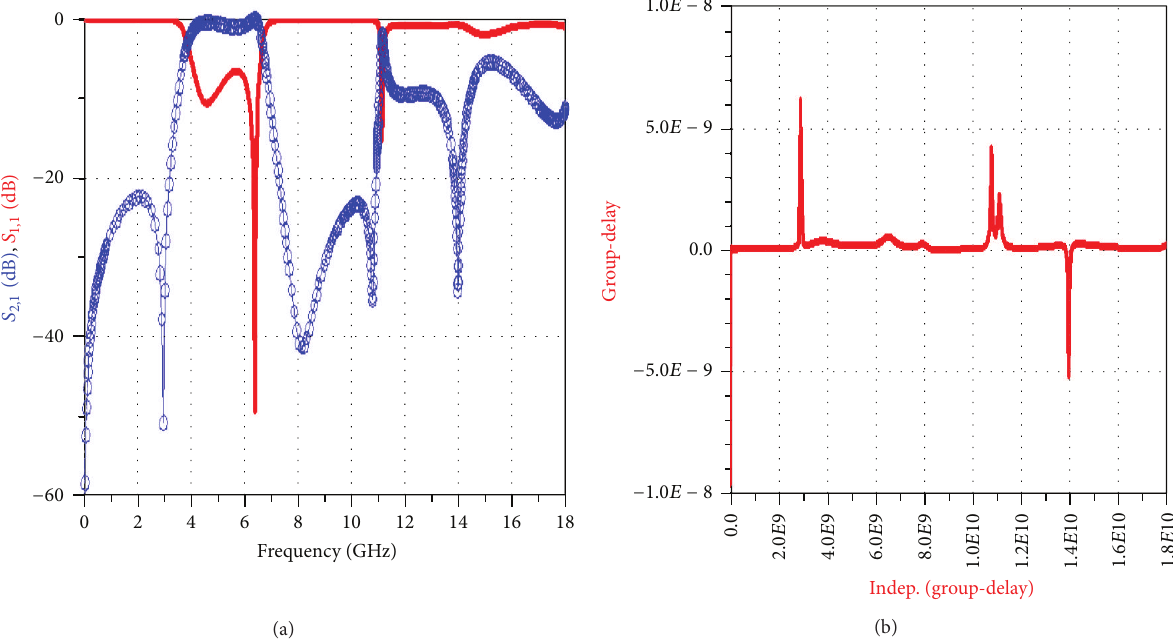
Figure 26: Frequency response of the simulated filter in the ADS program versus (a) return losses (𝑆 11 ) and insertion losses (𝑆 21 ) in the range of 0–16 GHz and (b) filter phase delay.